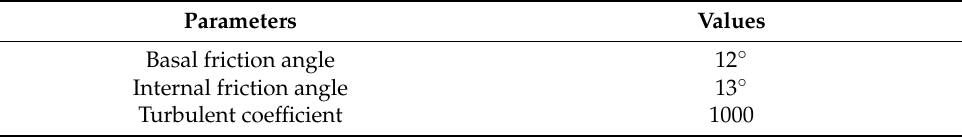
Table 3. Mechanical parameters of the Yigong landslide.